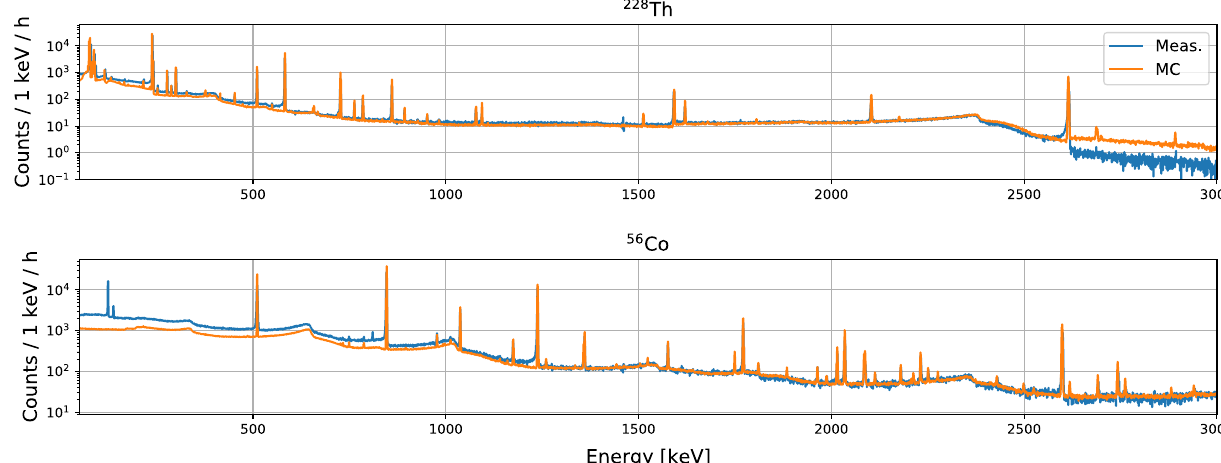
56 Co spectrum contains also contributions from 57 Co and 58 Co – iso- topes, which are also created in the proton activation (not included in the simulation, since they contribute only in the lower energy range)